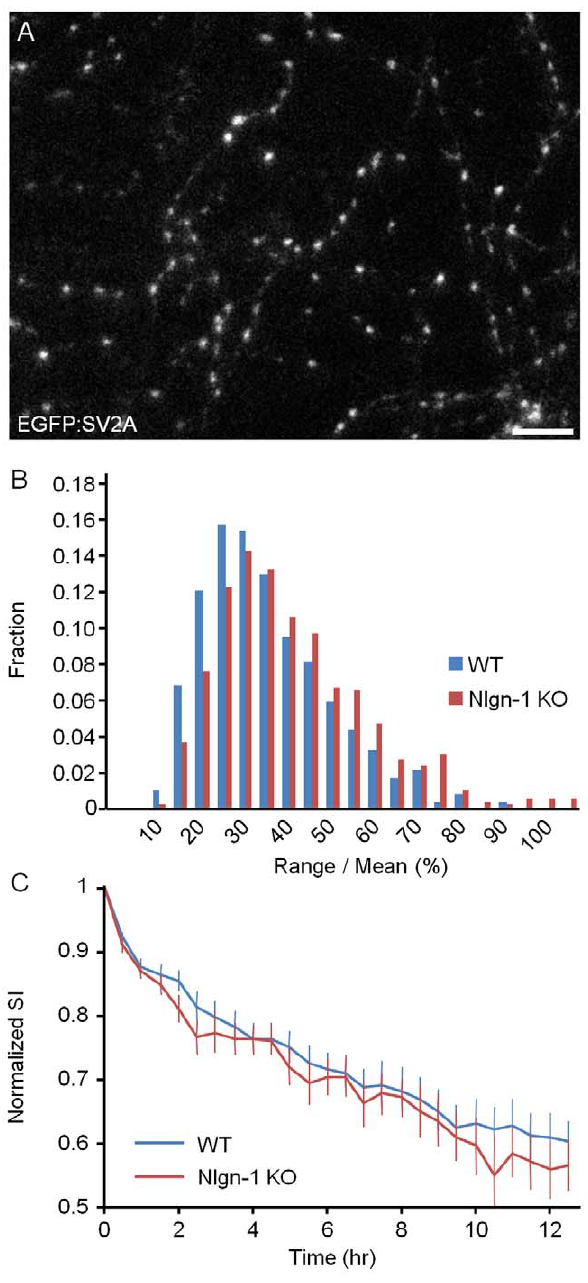
Figure 5. Constancy of synaptic vesicle contents at individual presynaptic sites. A ) Axons of a neuron from a WT mouse expressing EGFP:SV2A (22 days in vitro ). Individual fluorescent puncta represent presynaptic clusters of synaptic vesicles. Bar, 10 m m. B ) Distribution of range over mean values for all EGFP:SV2A puncta followed in these experiments (Nlgn-1 KO: 19 neurons, 599 boutons; WT: 21 neurons, 856 boutons). C ) SI decay rates measured in neurons from Nlgn-1 KO and WT mice (mean 6 SEM). doi:10.1371/journal.pone.0042314.g005 intervals (Fig. 6B) and the data was subjected to a similar analysis as described for PSD-95:EGFP and EGFP:SV2A. Comparisons of range over mean value distributions revealed significantly greater values in neurons from Nlgn-1 KO mice as compared to those from WT littermates (Fig. 6C; Nlgn-1 KO: 28.3 6 16%, 5